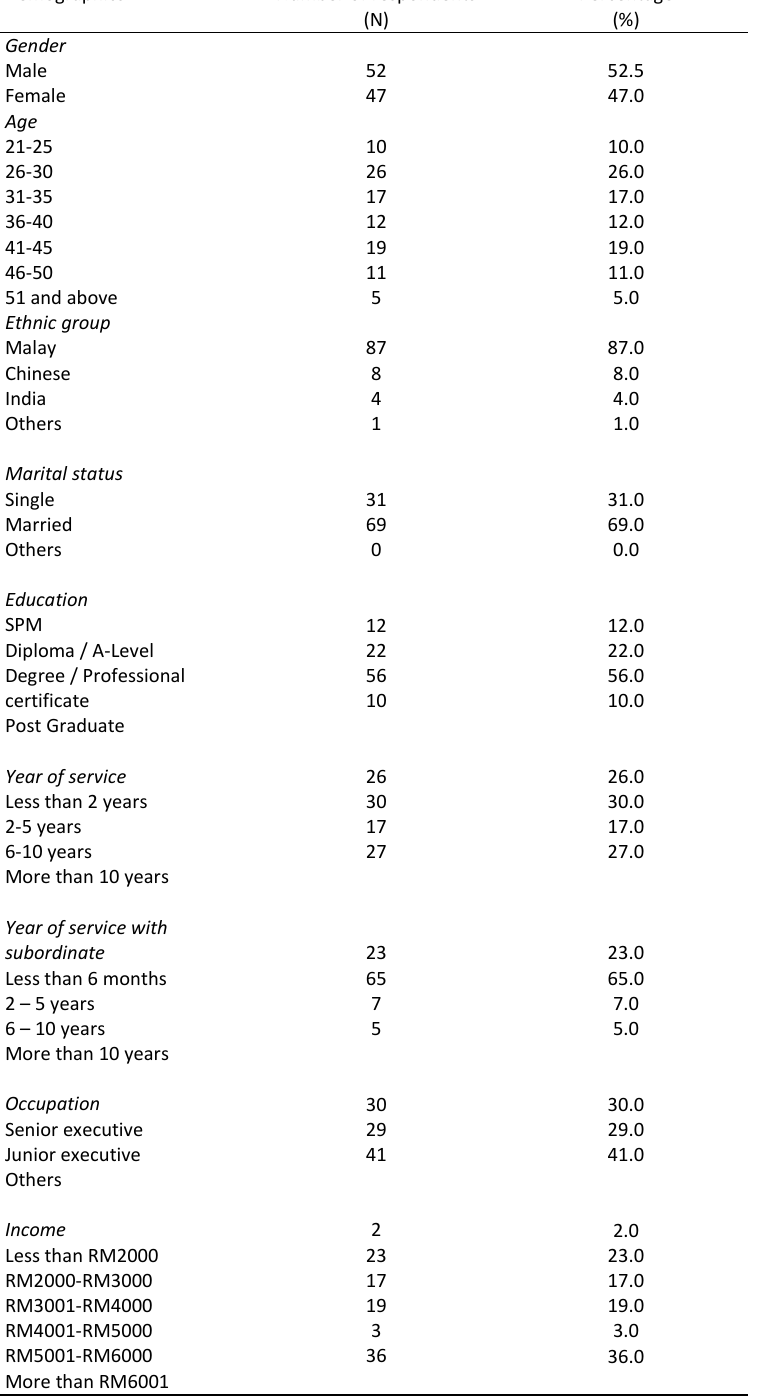
Table 3: Respondents' demographic profile Table 3. Respondents’ demographic